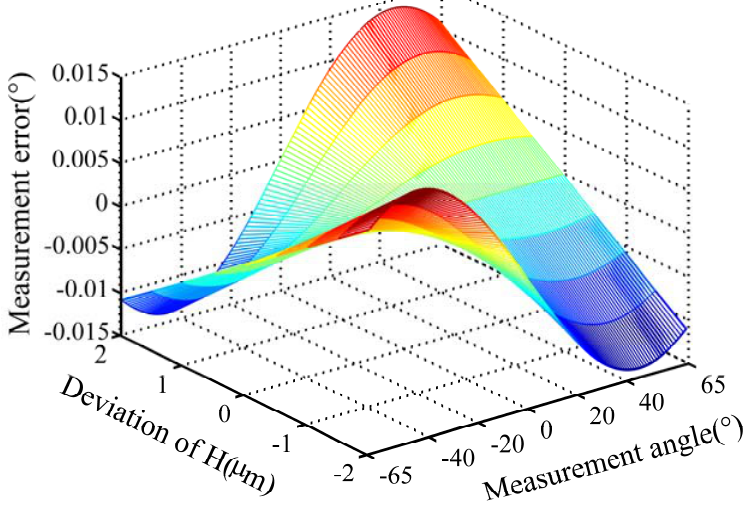
Figure 3. Measurement error caused by distance deviation Δ